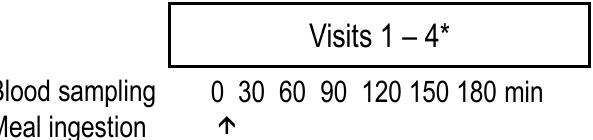
Figure 2. Overview of study design. Each participant underwent four visits (* between one to three weeks apart). The meals were allocated randomly (containing WPF or PPF 1–3). Each PPF product included a blend of plant protein sources and 20% pea fibre. Pea fibre (10 g) was also added to the whey-containing meal. PPF, plant protein fibre; WPF, whey protein fibre.